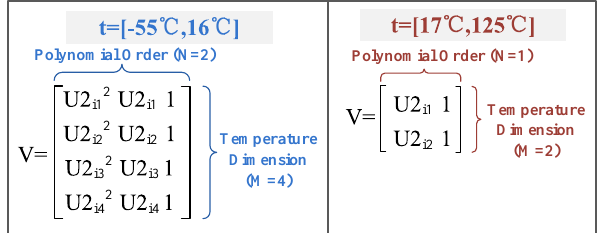
Figure 6. Structure of the Vandermonde matrix (in the low temperature range of − 55 ◦ C ≤ t ≤ 16 ◦ C, the matrix module computes with a higher degree N = 2, while in the temperature range of 17 ◦ C ≤ t ≤ 125 ◦ C, the matrix module computes with a lesser degree N =